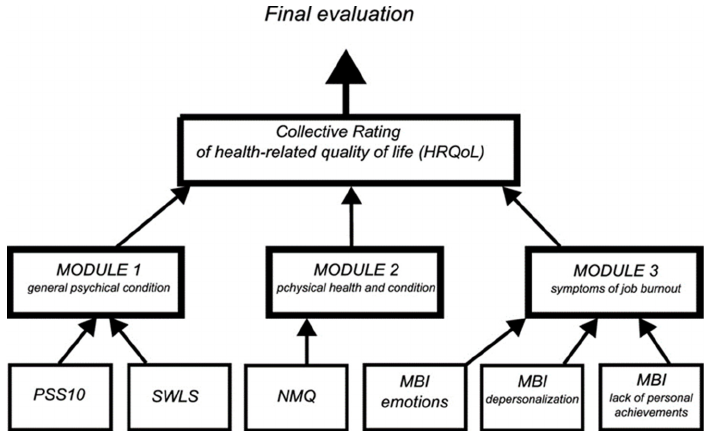
Figure 1. General structure of the proposed fuzzy system.